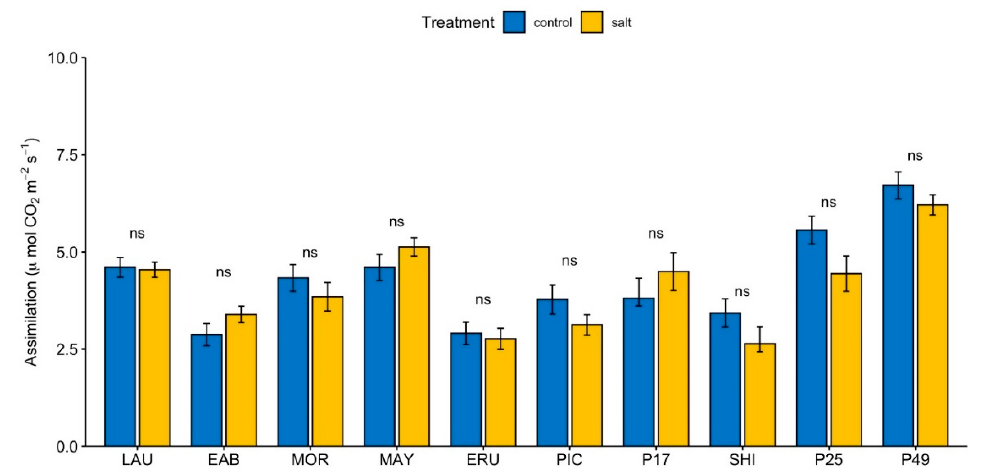
Figure 3. E ff ect of salinity on photosynthetic CO 2 assimilation. Measurements from three intermediate-aged leaves from each plant were averaged for one reading. Values are means of four independent experiments, each with at least four biological replicates per cultivar / accession per condition. Bars represent standard errors; asterisks indicate statistical significance as calculated by the t -test. * ( p ≤ 0.05), ** ( p ≤ 0.01), *** ( p ≤ 0.001), **** ( p ≤ 0.0001), ns = not significant ( p > 0.05). Table 2. Vapor pressure deficit based on leaf (VpdL) in control and salinity treatments. Cultivar